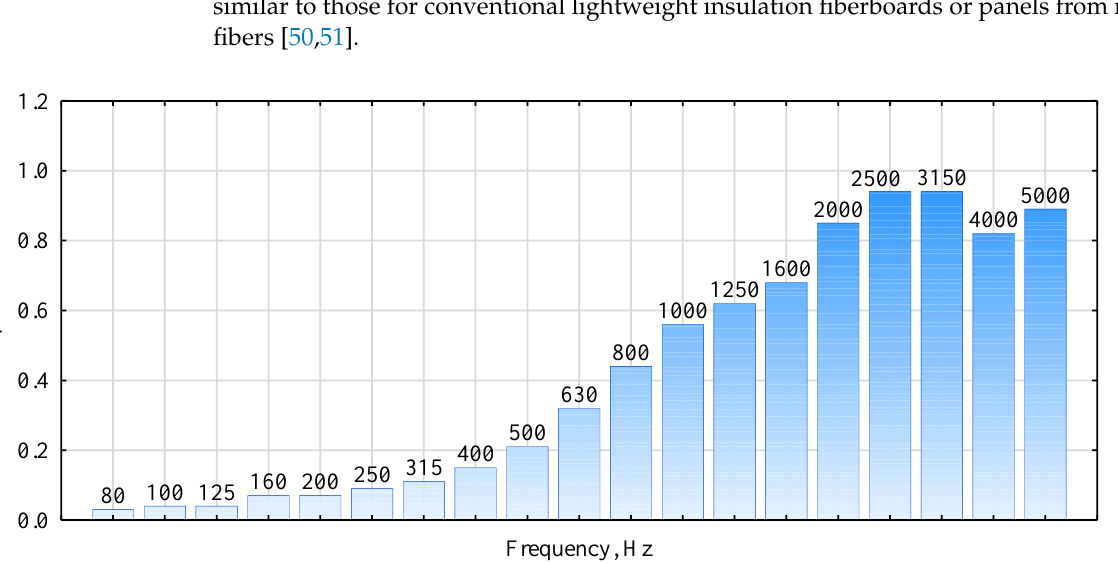
Figure 4. Absorption coefficient of fiberboard glued with E1404.